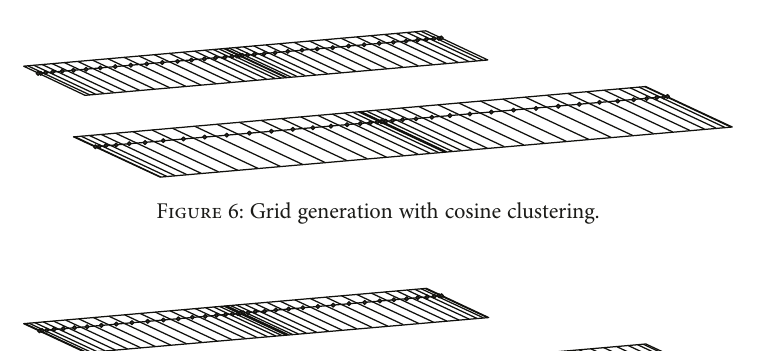
Figure 5: Grid generation for equal spanwise increment.